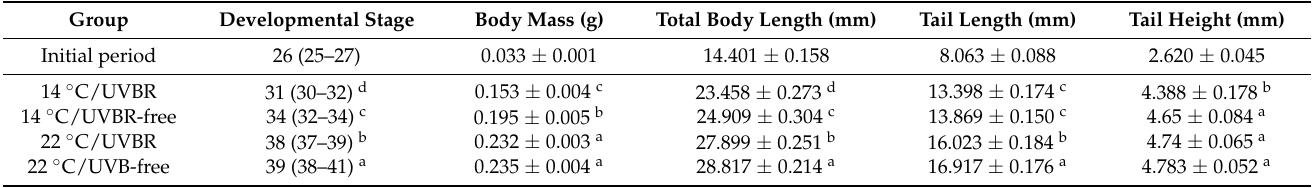
Figure 1. Effect of UVBR (solid lines) and UVBR–free (dashed lines) environments in combination with either a 14 (blue lines) or 22 °C (red lines) temperature on the survival of Rana kukunoris tadpoles. Lines show the trend in mortality for each treatment over the 21 day exposure period. The survival of tadpoles in the 14 °C/UVBR group was only 65%, which was lower than that in the other three groups. Table 1. Variation in the developmental rate, body weight, and body length of R. kukunoris tadpoles. The developmental stages are expressed in Gosner modes (1960). The body mass and total body length are represented as mean ± SE. Lowercase letters above bars denote significant differences between